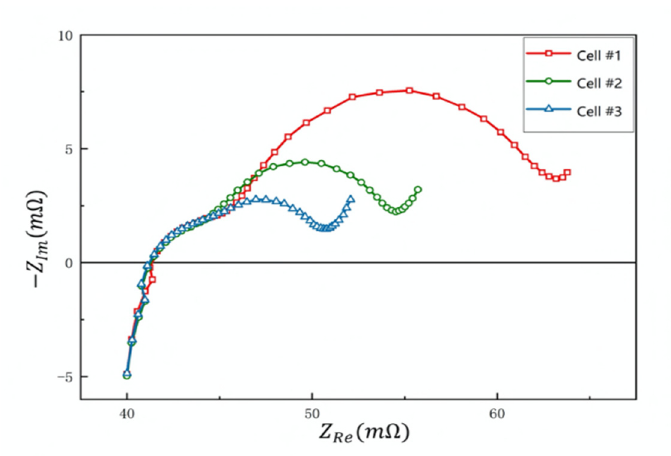
Figure 3. Nyquist plot of EIS measurement for cell #1 (2650 mAh), cell #2 (2850 mAh) and cell #3 (3050 mAh).